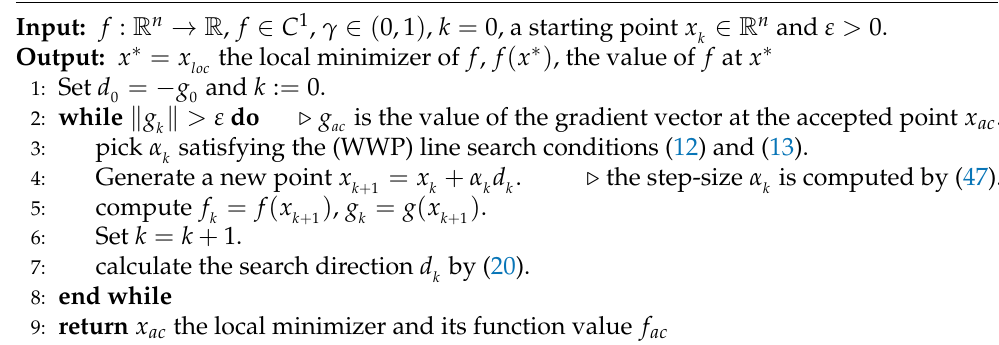
Algorithm 1 A new modified CG